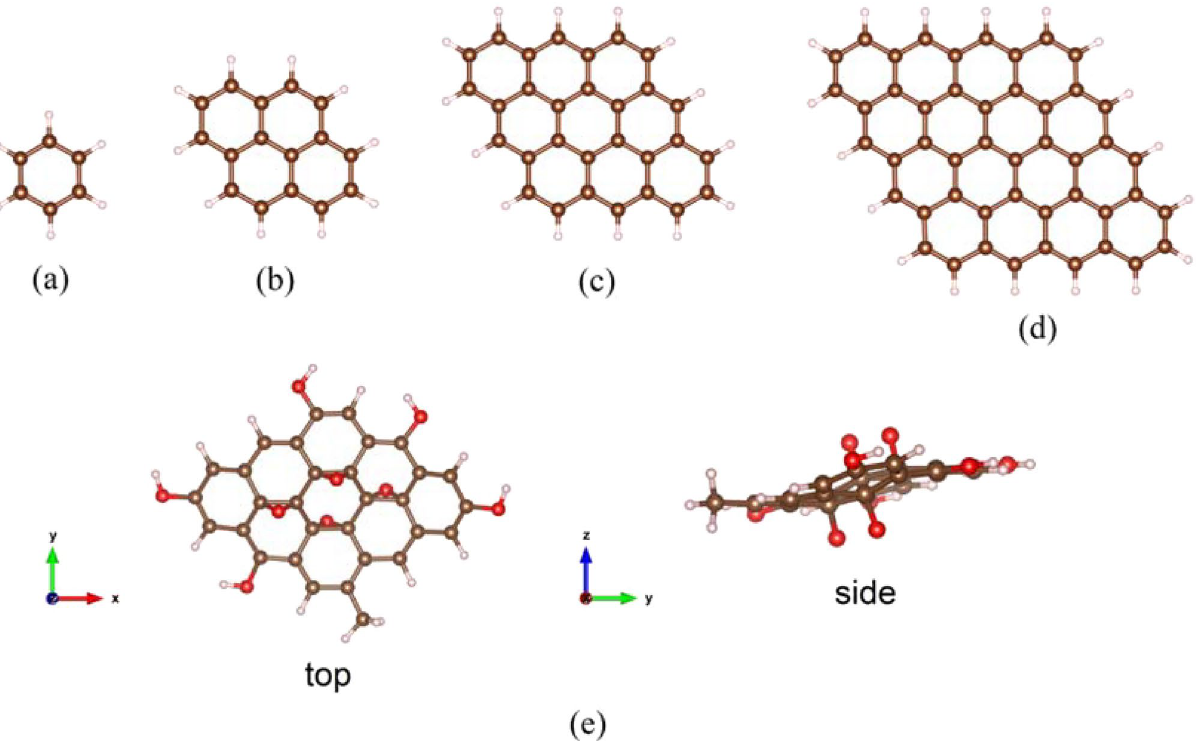
Figure 1. The initial molecular structure of Benzene ( a ), Pyrene ( b ), p1GQD ( c ), p2GQD ( d ), and fGQD with top and side views ( e ). Dark gold spheres represent carbon atoms, light white spheres hydrogen atoms, and red spheres oxygen